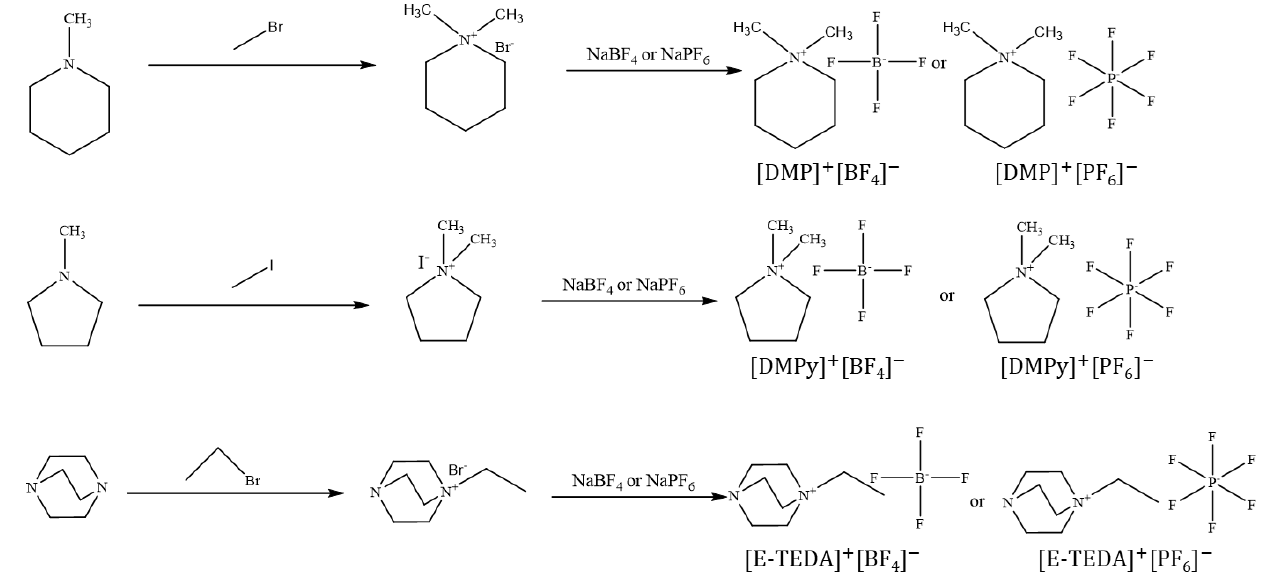
Figure 2. Schematic synthesis of the N-heterocyclic aliphatic salts by SN2 reaction.